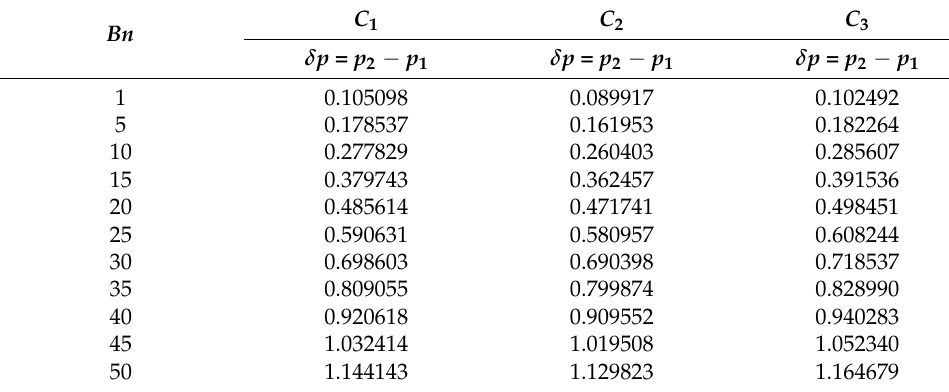
Table 2. Pressure drop for different positions of obstacle.